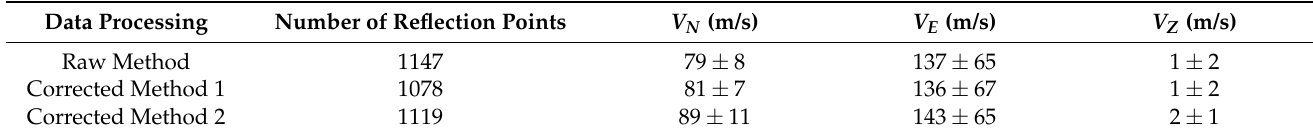
Table 2. Numbers of reflection points and drift velocity components obtained by raw method,